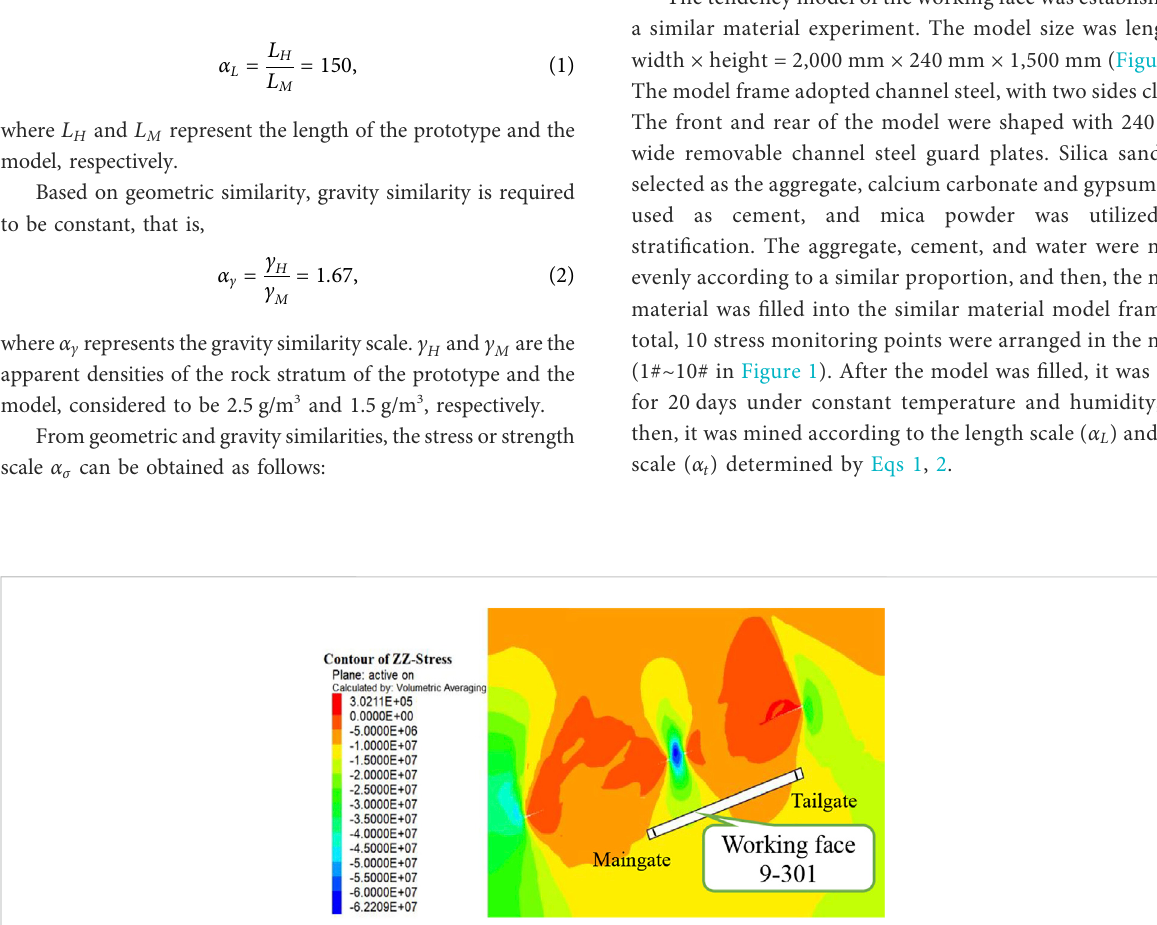
FIGURE 4 Mining model.